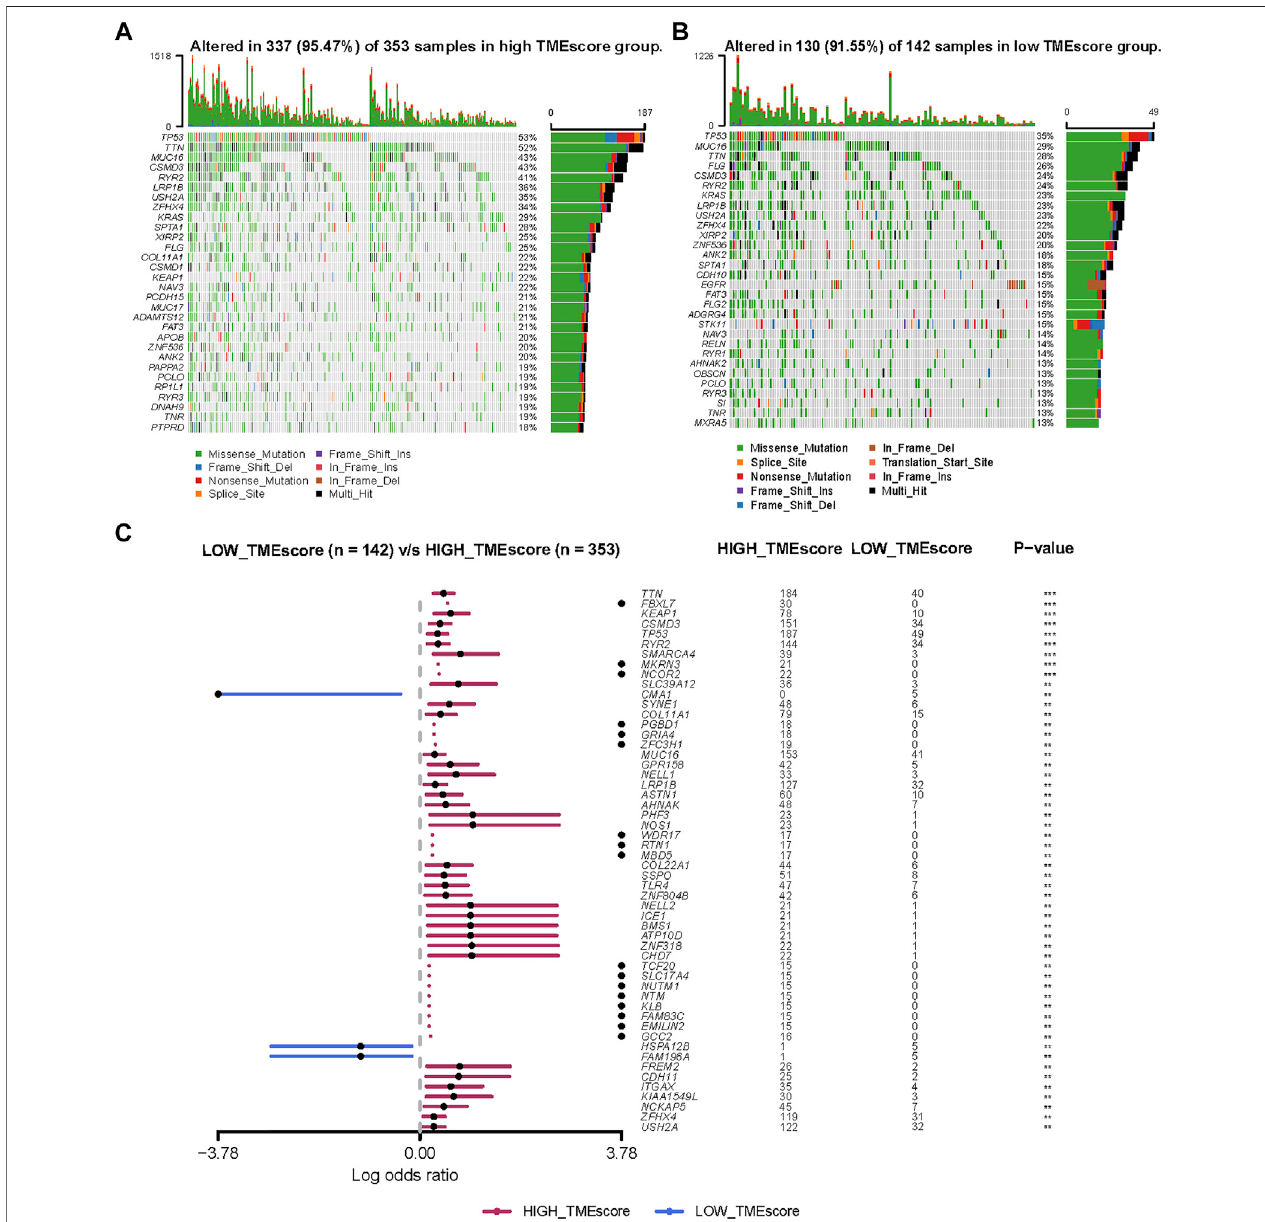
FIGURE 5 | Molecular variations between low-TMEscore and high-TMEscore groups. (A and B) Mutation pro fi les of high-TMEscore and low-TMEscore groups. (C) Comparing differentially mutated genes between two subgroups by Fisher ’ s exact tests.